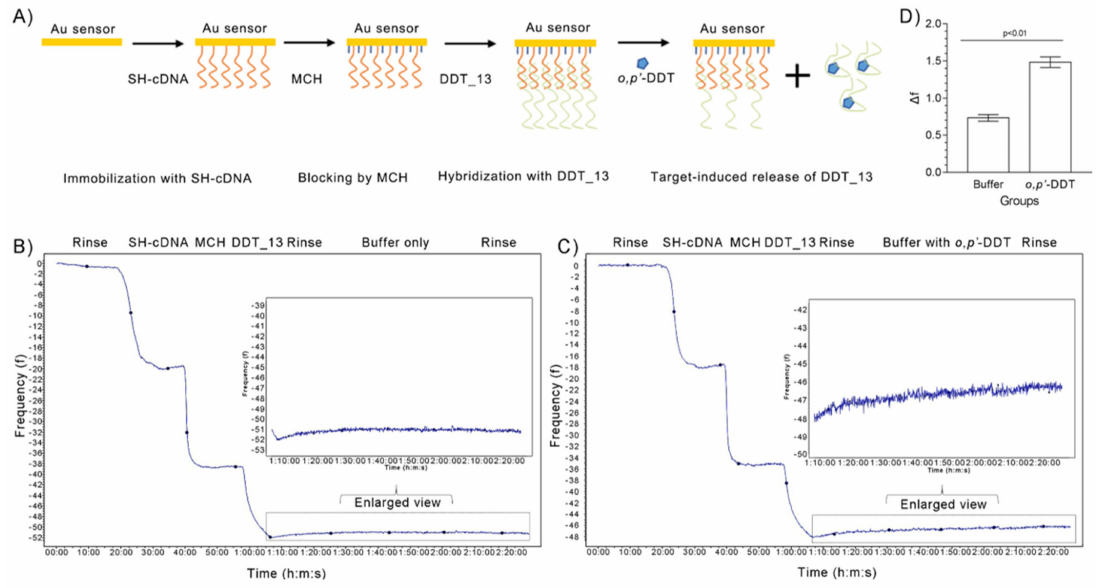
Figure 4. Binding tests by quartz crystal microbalance (QCM) assay between DDT_13 and its target o,p’ -DDT. ( A ) Detection principle of QCM. ( B , C ) QCM analysis of binding a ffi nity of DDT_13 without ( B ) and with its target o,p’ -DDT ( C ) in binding bu ff er. ( D ) The changes of the f value ( ∆ f) of the sensor crystal after binding without and with o,p’ -DDT,